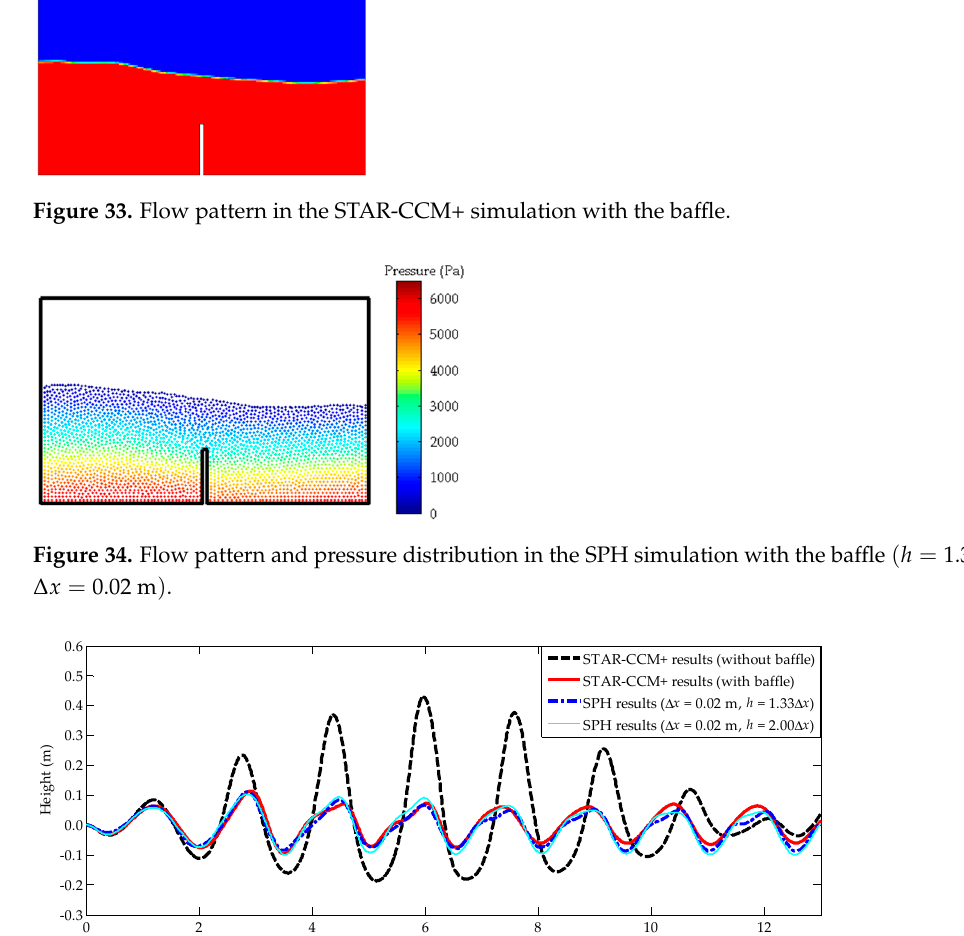
Figure 35. Comparison of the wave elevation at the wave gauge obtained by the SPH and STAR-CCM+ simulations.